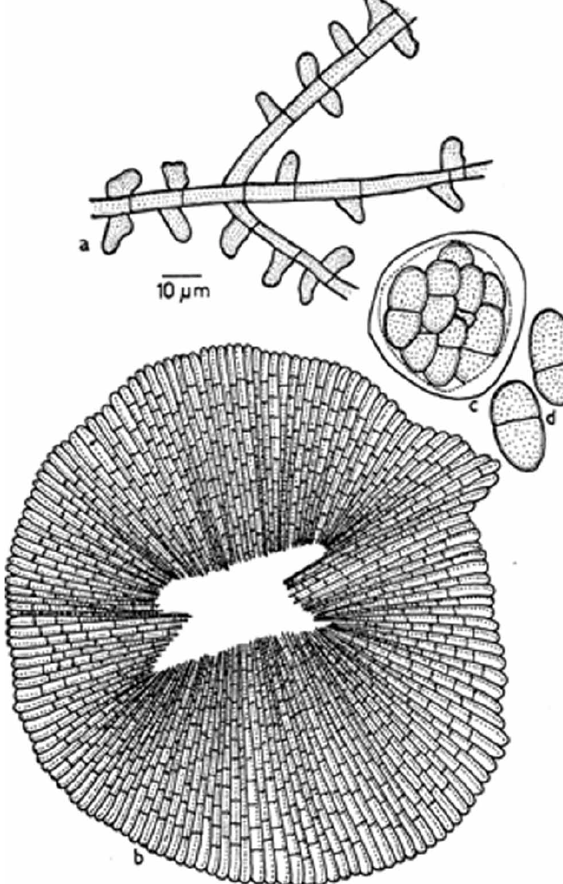
Figure 170. Asterina trichiliae a.Appressorium, b. Thyriothecium, c. Ascus, d. Ascospores